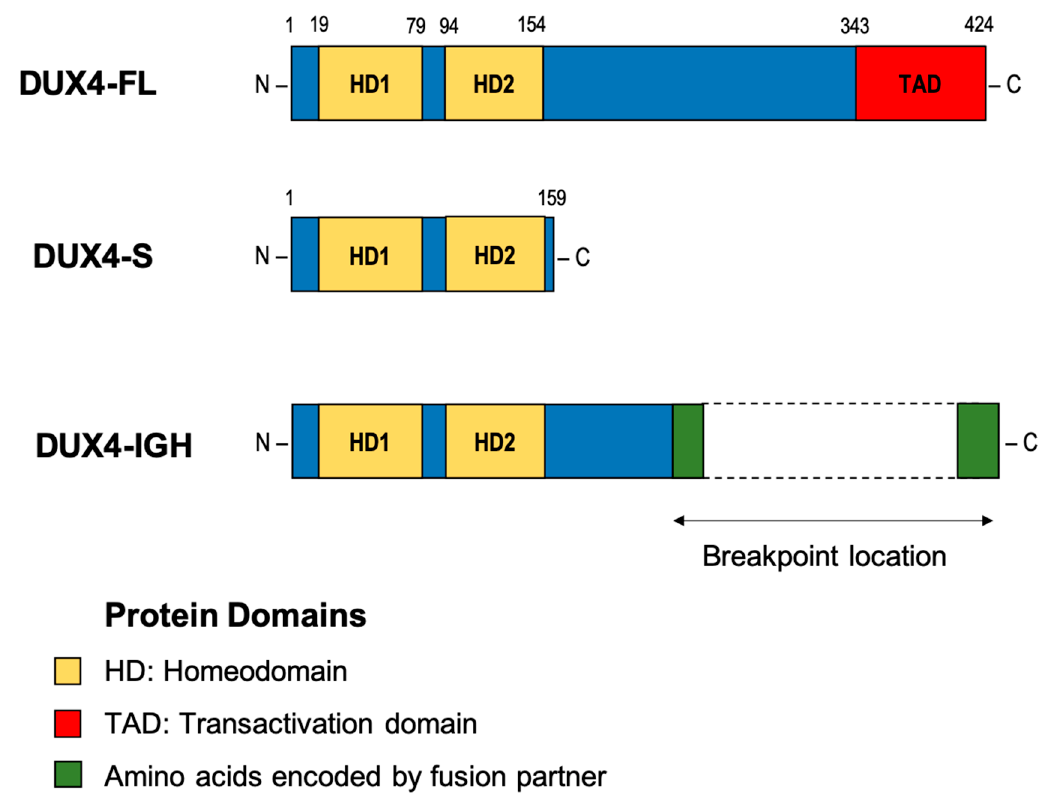
Figure 2. Deduced proteins of the various forms of DUX4. Full-length DUX4 (DUX4-FL) and truncated DUX4 (DUX4-S) generated from an alternatively spliced transcript of DUX4 ( DUX4-s ) lacking the C-terminal transactivation domain. Putative DUX4-IGH chimeric protein in which the C-terminal portion of DUX4 containing the transactivation domain is replaced with amino acid sequence encoded by the genomic location into which DUX4 was inserted. Length of the C-terminal portion of the chimeric protein can vary between patients, depending on the breakpoint location within exon 1 of DUX4 .